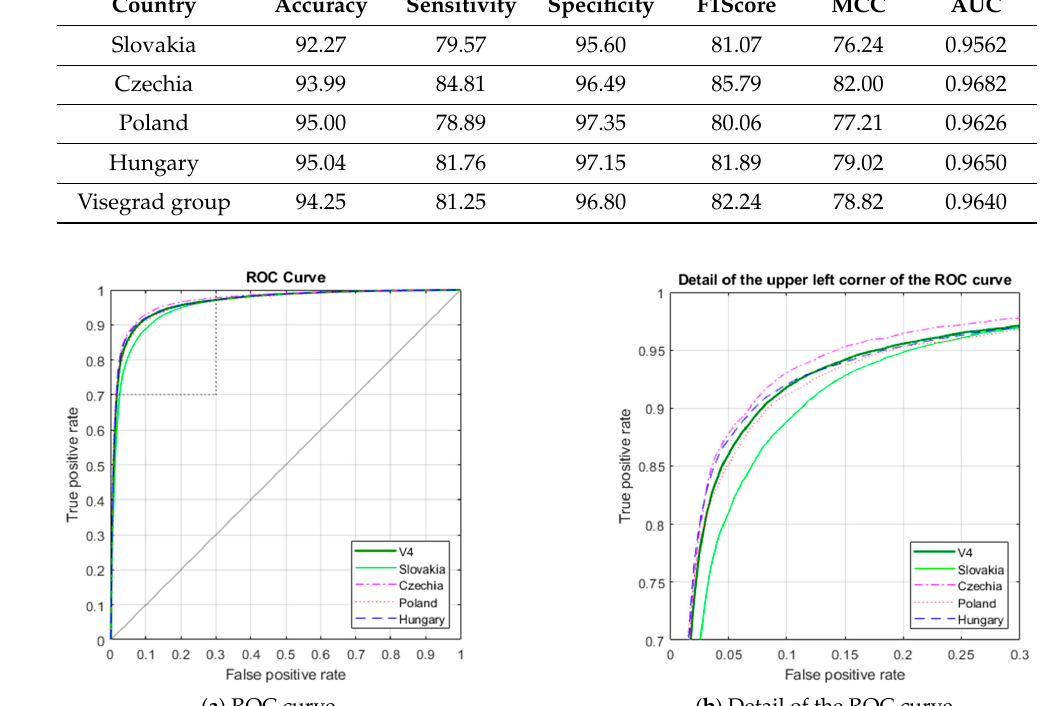
Table 11. The performance metrics of models.